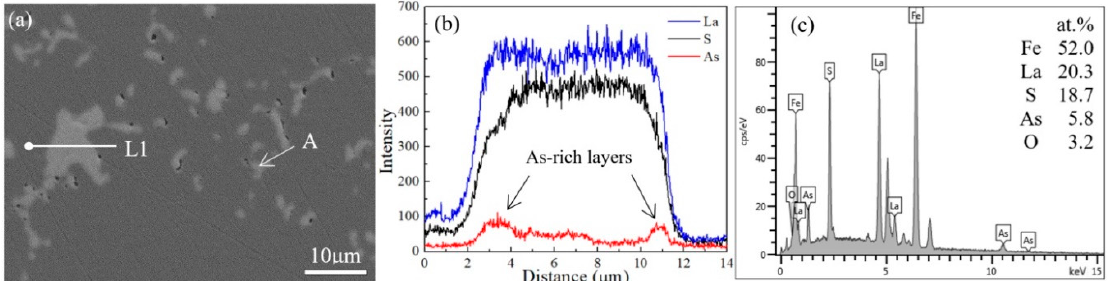
Figure 3. Morphologies and chemical compositions of LaS and La-S-As inclusions at the top surface. ( a ) Morphologies of inclusions; ( b ) line scanning of position L1; ( c ) energy dispersive spectrometer (EDS) of position A.